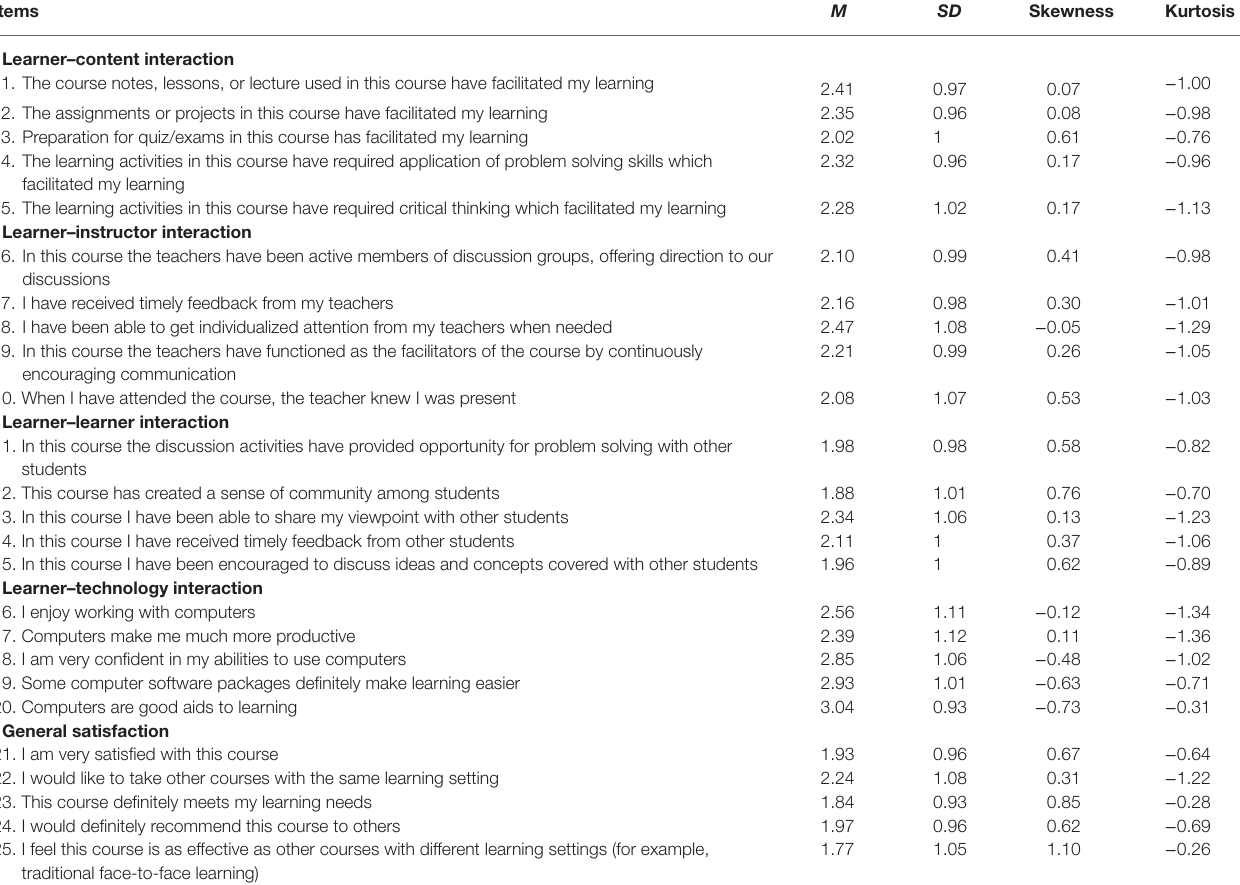
TABLE 2 | Means (M), standard deviation (SD), skewness, and kurtosis for items of the LSS-S ( N = 1,194). Items M SD